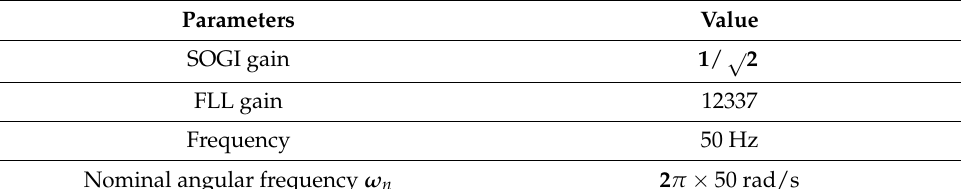
Table 1. SOGI Parameters.